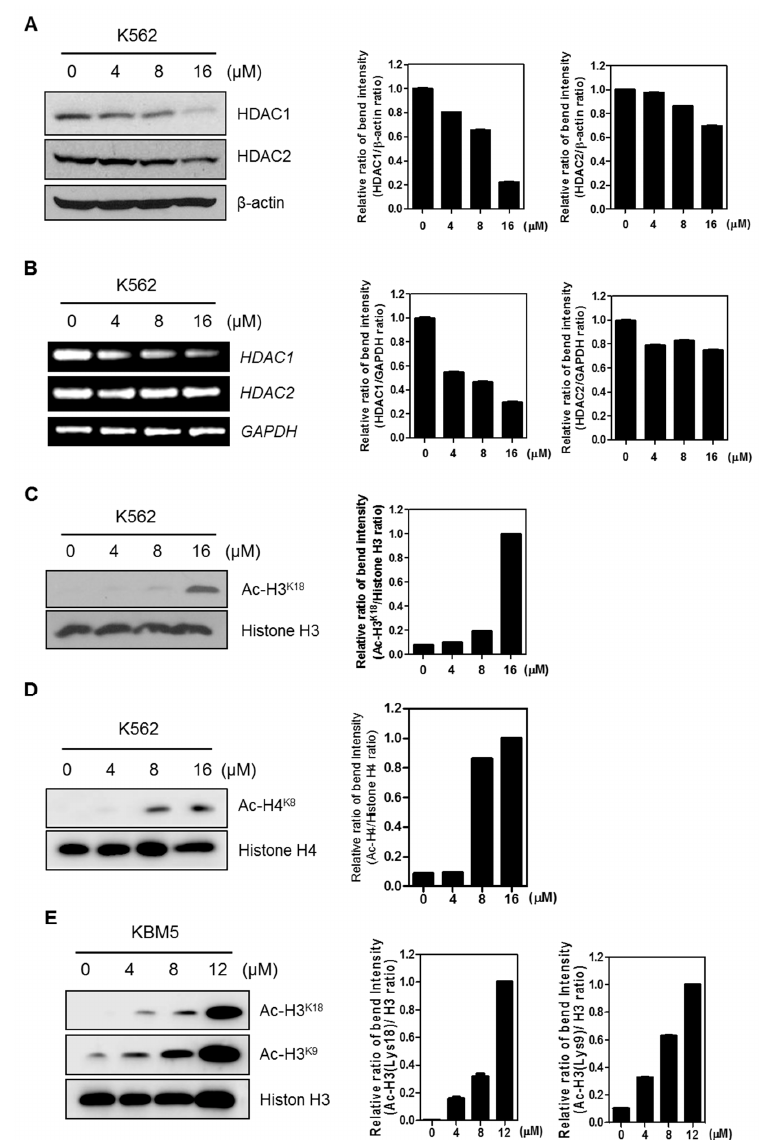
Figure 4. FC inhibits the expression of HDAC1 and 2 at protein and mRNA levels, and induces acetylation of H3 K9 , H3 K18 , and H4 K8 in CML cells. ( A ) E ff ect of FC on HDAC1 and HDAC2 in a concentration dependent manner in K562 cells. Cell extracts were prepared and subjected to Western blotting with antibodies of HDAC1 and 2. β -actin was used as an internal control. ( B ) E ff ect of FC on HDAC1 and HDAC2 in a concentration dependent fashion in K562 cells at mRNA level. Isolated RNAs were subjected to RT-PCR for HDAC1 and 2. Glyceraldehyde 3-phosphate dehydrogenase (GAPDH) was used as an internal control. ( C , D ) E ff ect of FC on acetylation H3 (K18) or H4 (K8) in K562 cells. Cell extracts were prepared and subjected to Western blotting with acetylation H3 (K18) or H4 (K8) antibodies. Histone H3 or H4 were used as an internal control. ( E ) E ff ect of FC on acetylation of H3 (K18) or H3 (K9) in KBM5